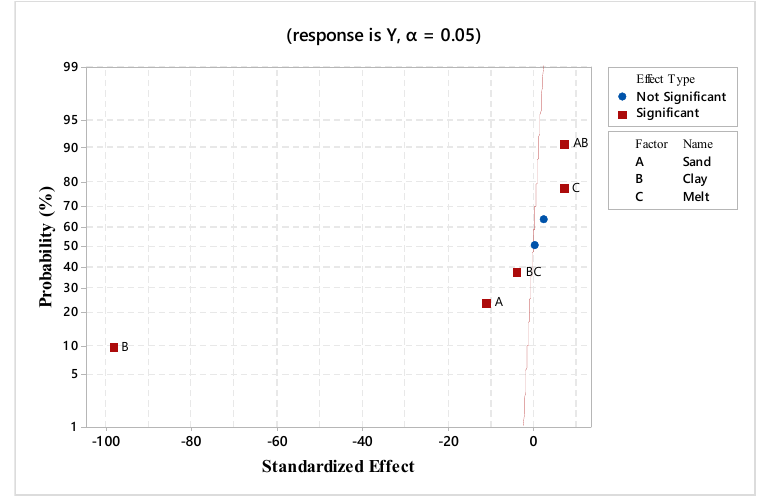
Figure 7. Normal probability plot of the effects.